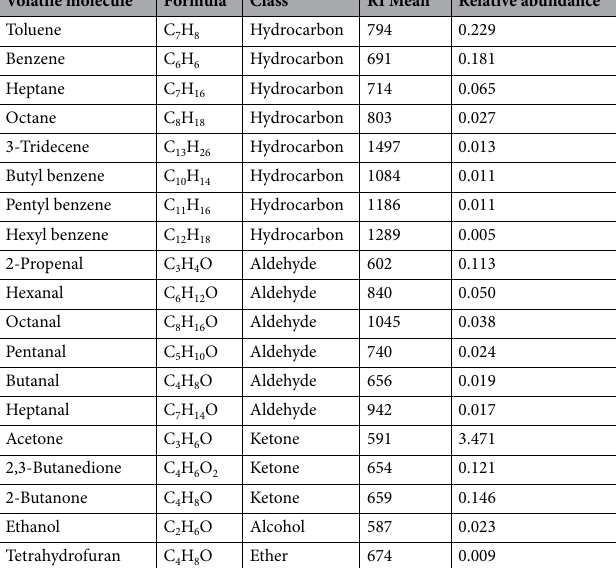
Table 2. Putatively identified volatile molecules that are statistically non-significant between the pre-flowering and the flowering phases. The p -values were not corrected for multiple comparison adjustments. a